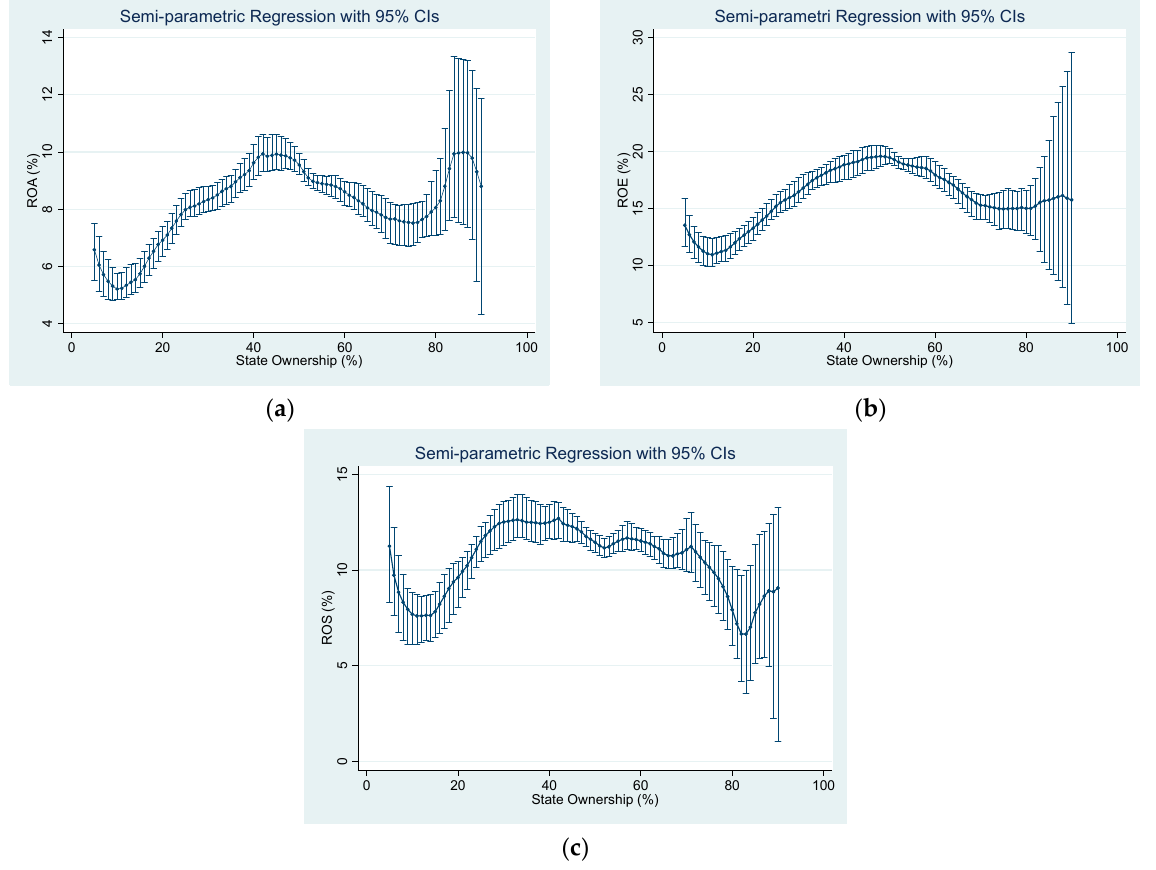
Figure 1. Semiparametric estimates of firm’s ROA ( a ), ROE ( b ), and ROS ( c ) on state ownership (%). This figure presents the marginal effect of state ownership on partially privatized firm’s ROA (%), ROE (%), and ROS (%). The continuous lines correspond to the estimates, whereas the capped spikes correspond to the 95% confidence intervals. Table 3. Semiparametric regressions of partially privatized firm market performance against residual state ownership and control